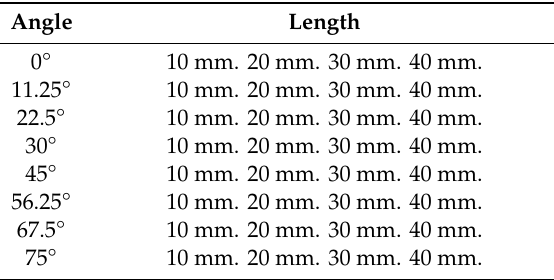
Table 1. Crack parameters values.